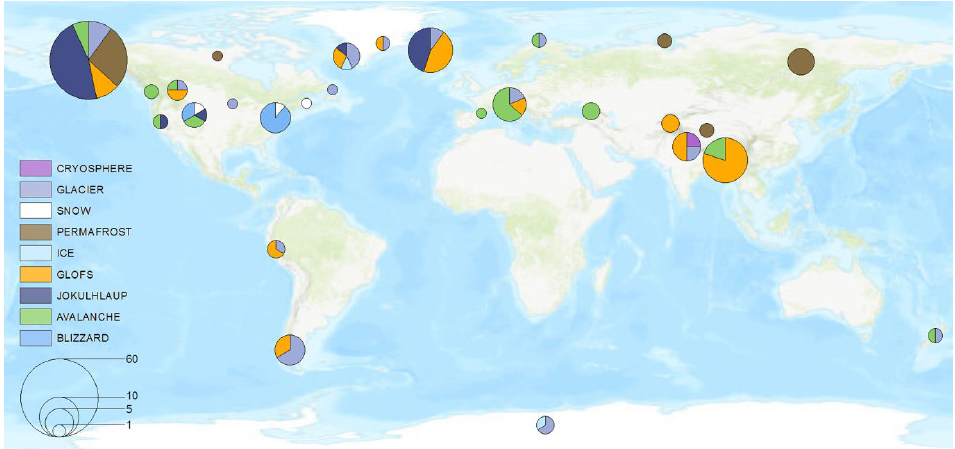
Figure 3. Location of videos with factual cryospheric content. Note differences in the presence and the share of individual keywords among the regions.